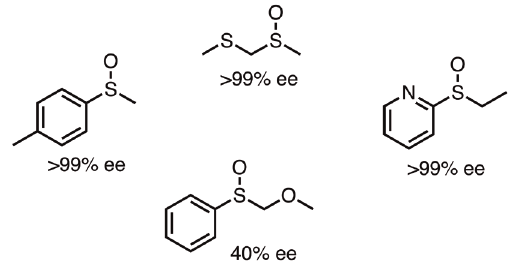
Figure 19 - Substrates used by Hanlon et al. (1998) for deoxygenation with dimethyl sulfoxide reductase.